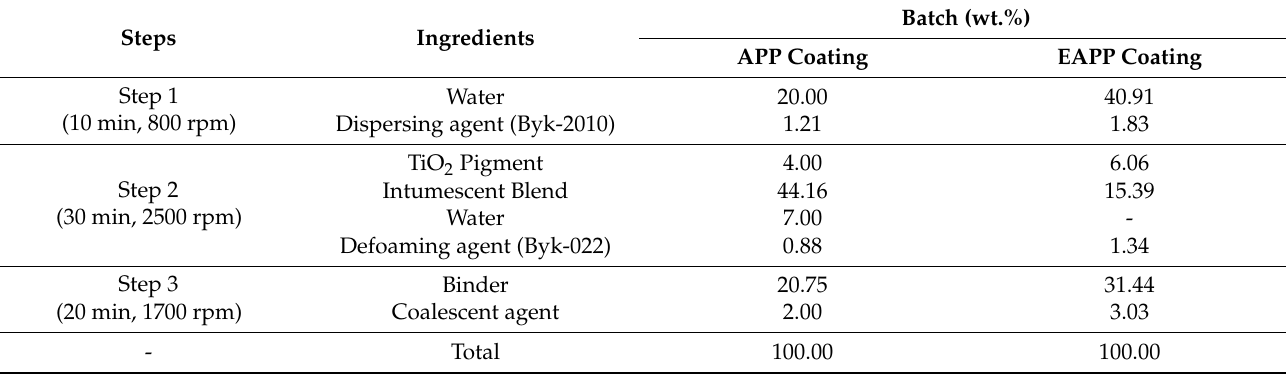
Table 4. Basic formulation for the intumescent waterborne